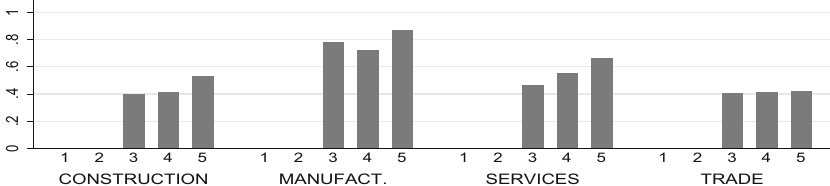
Fig. 5 Spain-to-EU4 productivity ratio by firm size and sector. Notes Each bar plots the ratio of average productivity in Spain to average productivity in the remaining EU4 countries (Germany, France, and Italy). The five size categories reported are: (1) from 1 to 9 employees; (2) from 10 to 19 employees; (3) from 20 to 49 employees; (4) from 50 to 249 employees; (5) more than 250 employees. Labor productivity figures cover the period 2002–2013 in the case of EUROSTAT and the year 2010 in the case of the OECD. Total factor productivity ratios from AMADEUS and COMPNET refer to the period 2004–2012 reveals that Spanish firms perform worse than their EU4 counterparts in all the three factors, which may explain, at least partially, their dismal performance in terms of